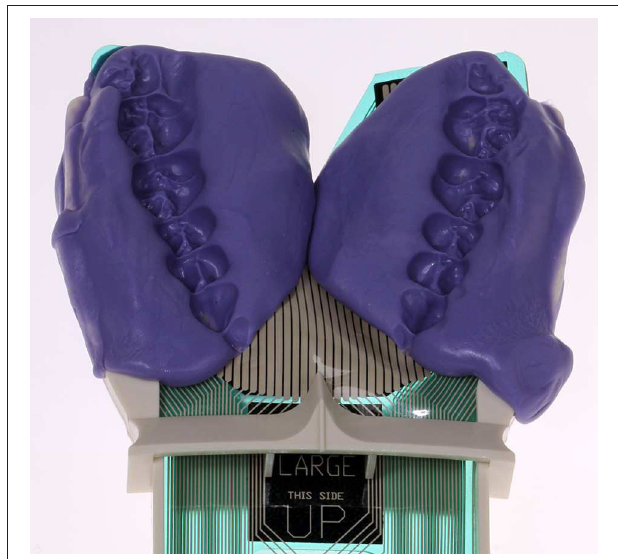
FIGURE 2 | Individually adjusted piezoelectric T-Scan sensor foil (Tekscan Inc., USA) with individually adjusted surface (dental silicone, Honigum, DMG, Hamburg) to compensate for dental or skelettal anomalies and to ensure a reproducible position in each